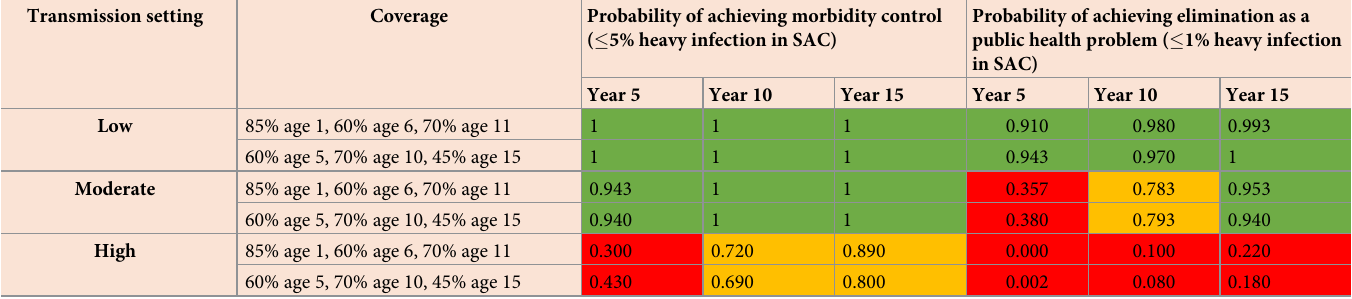
Table 6. Probability of reaching the WHO 1% elimination as a public health problem goal and the 5% SAC 5% morbidity goal for vaccination only with different coverage levels. The duration of protection is set at 5 years. Green shaded areas = probability of reaching target > 90%, Yellow shaded areas = 0.5 � probability of reaching target < 0.9, Red shaded areas = probability of reaching target < 0.5.